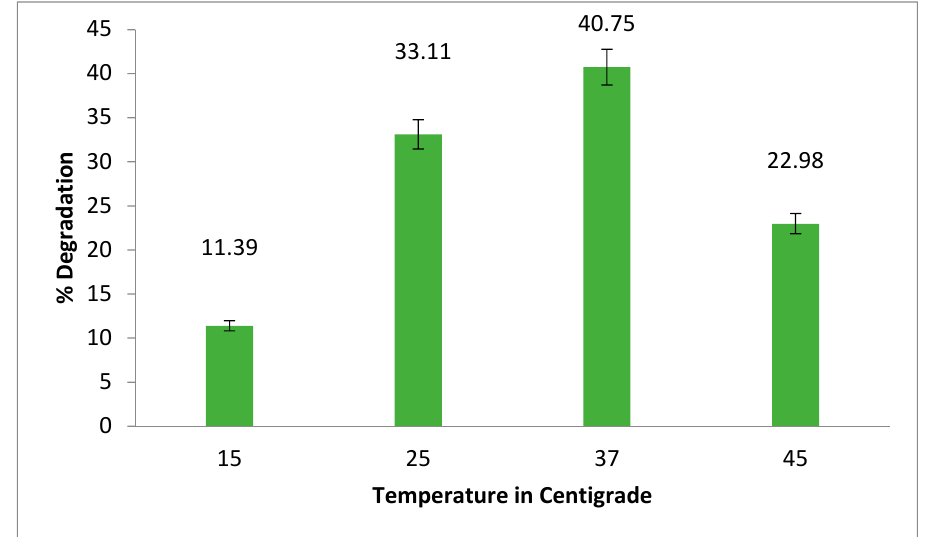
Figure 5. Temperature effect on % degradation of brown 706.